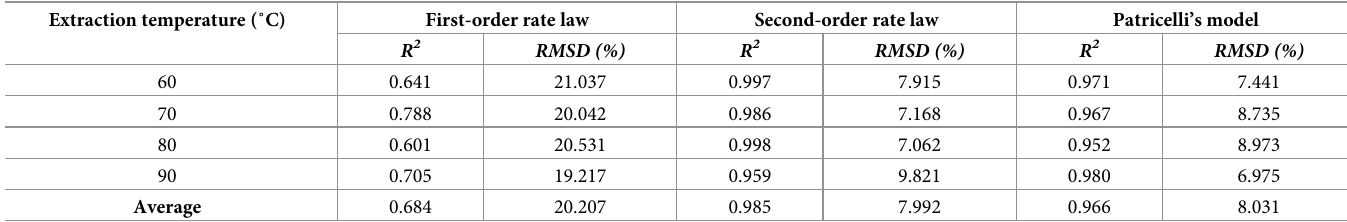
Table 5. Statistical parameters of the kinetic modelling for MAILE of extracted EPA. Extraction temperature (˚C)